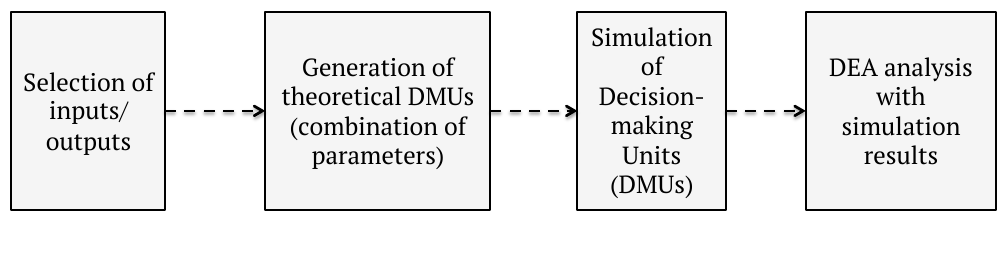
Figure 4. Methodology workflow employed in this work. DEA, data envelopment